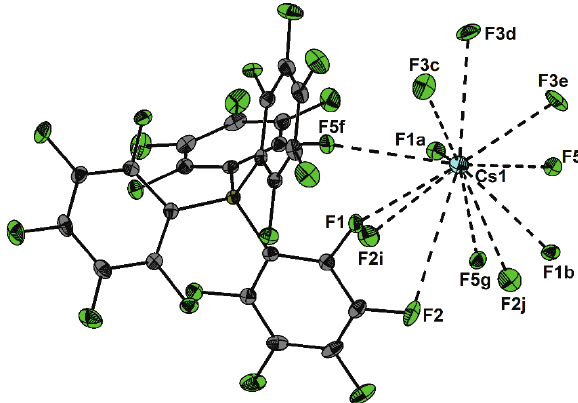
F ) ] ( 2 ) showing 50% 6 5 4